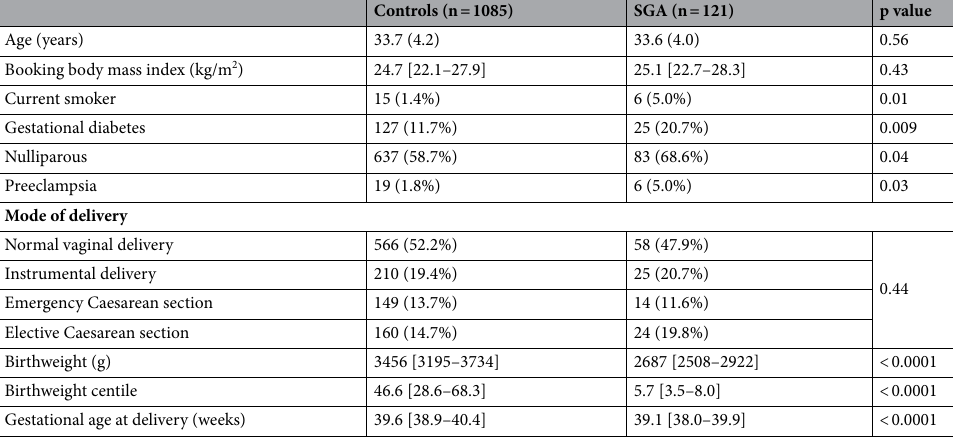
Table 1. Maternal characteristics and pregnancy outcomes for Cohort 1, Samples collected at 36 weeks’ gestation in Sydney Australia. Data represented as mean (standard deviation) if normally distributed, as median [interquartile range] if not normally distributed, or as number (%) if categorical. SGA small-for- gestational-age (GROW birthweight < 10th centile). Some percentages do not sum to 100% due to rounding to one decimal